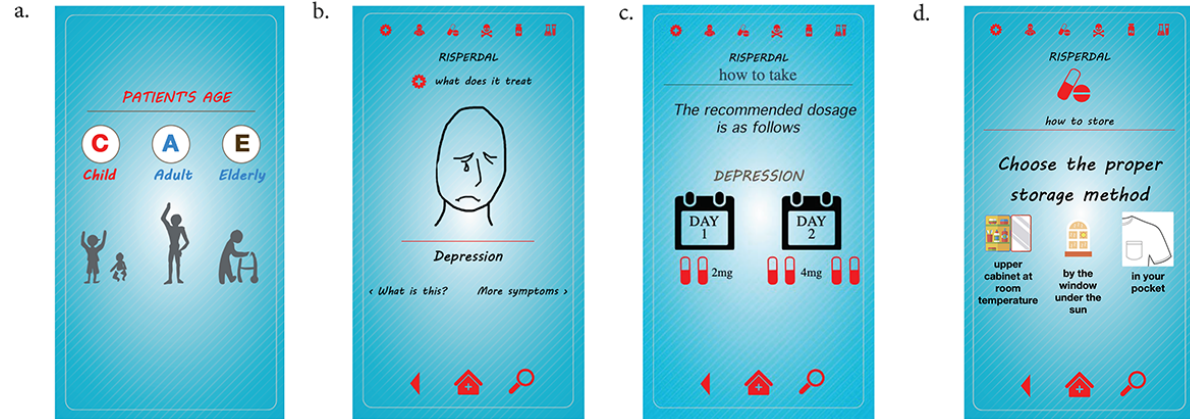
Figure 3. Screenshots from the mobile app: (a) screen showing age-based differences, (b) graphical representation of depression, (c) dosage for depression, (d) screen in which users are asked to choose the proper storage method for the